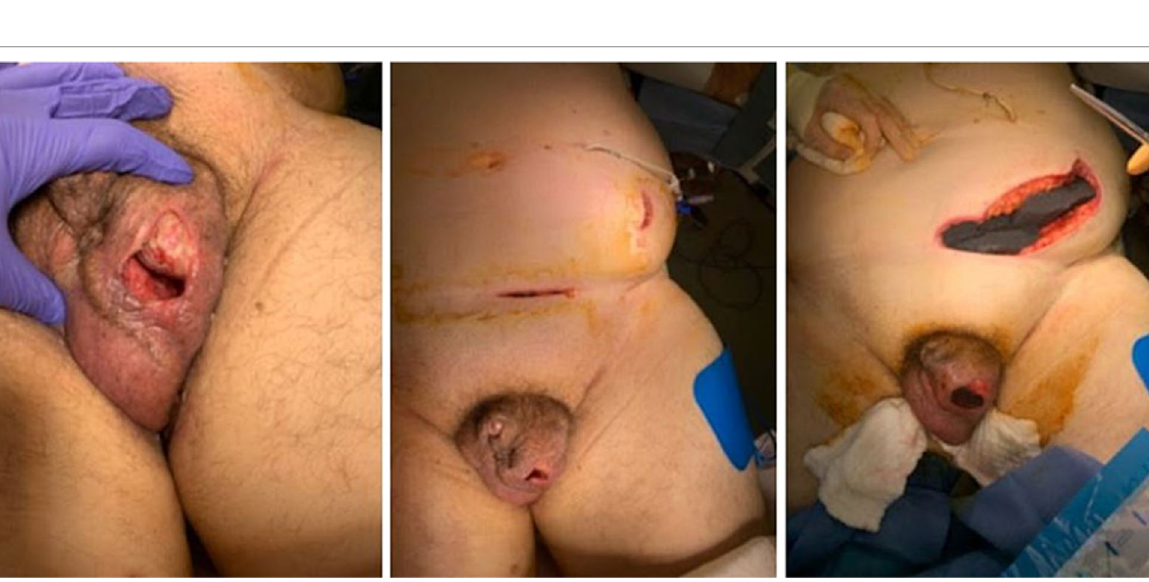
Fig. 5 Intraoperative images of scrotal incision (left), suprapubic and left lower quadrant abdominal incisions (middle) that were subsequently connected (right) for negative pressure wound